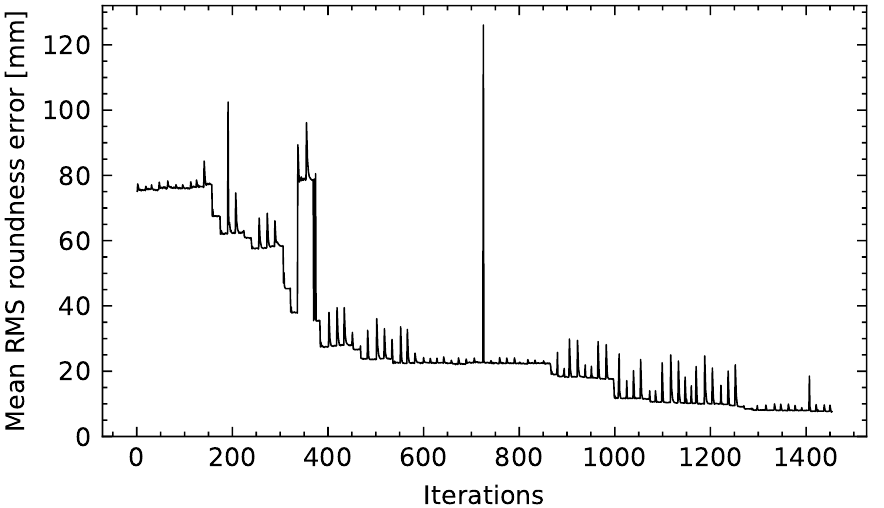
Figure 4. Progress of the optimization. For each iteration, Powell’s conjugate direction method was used to obtain new control point values for estimating the target function.